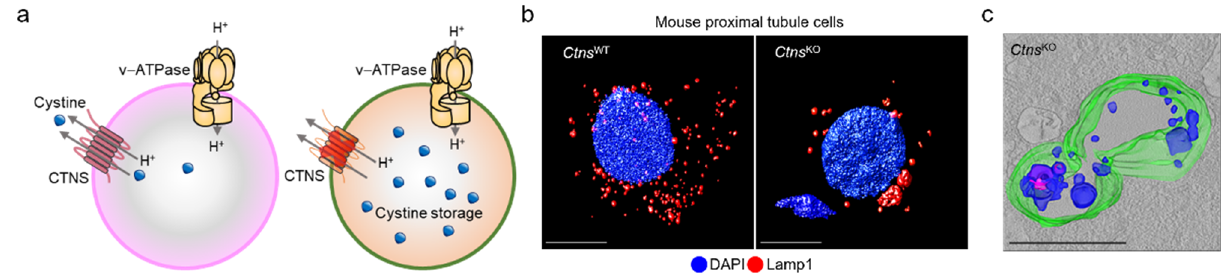
Figure 3. Cystinosin: from endolysosome to disease. ( a ) Cystinosin works in tandem with v-ATPase to transport cystine from the endolysosome, and its absence triggers ( b , c ) the storage of cystine within enlarged endolysosomes in primary proximal tubule cells derived from mouse kidneys. Adapted from Festa et al. [62].